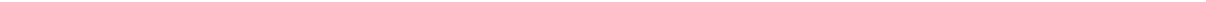
Fig. 6 Alteration of PolD1 expression affects Golgi organization. a RPE1 cells were transfected with control or PolD1 siRNAs. Anti- α -tubulin fl uorescence intensities were measured at the Golgi area, and the background intensity was obtained from cytoplasmic areas lacking microtubules. Here, the average microtubule intensities per pixel at the Golgi are presented after subtraction of the background. The Golgi area was outlined according to TGN46 staining by using the freehand selection option in ZEN software. Data are shown as means ± s.d. of three experiments; ** p < 0.01, * p < 0.05, two-tailed, unpaired student ’ s t -test; control, n = 60 cells; PolD1 depletion, n = 50 cells per experiment. b Cells were transfected with GFP or GFP-PolD1 and then immunostained for GM130 and GCP6; n = 50 cells from three independent experiments. c RPE1 cells transfected with control or PolD1 siRNAs were treated with nocodazole. After nocodazole washout, Golgi reassembly was examined at the indicated time points. TGN46 immuno fl uorescence was used to measure the size of the Golgi particles that were not clustered in the Golgi region surrounding the centrosome. Quanti fi cation graphs show the average size of the individual particles and the total area of the particles. Data are presented as means ± s.e.m. of three experiments (30 cells analyzed per condition). Scale bars , 10 μ